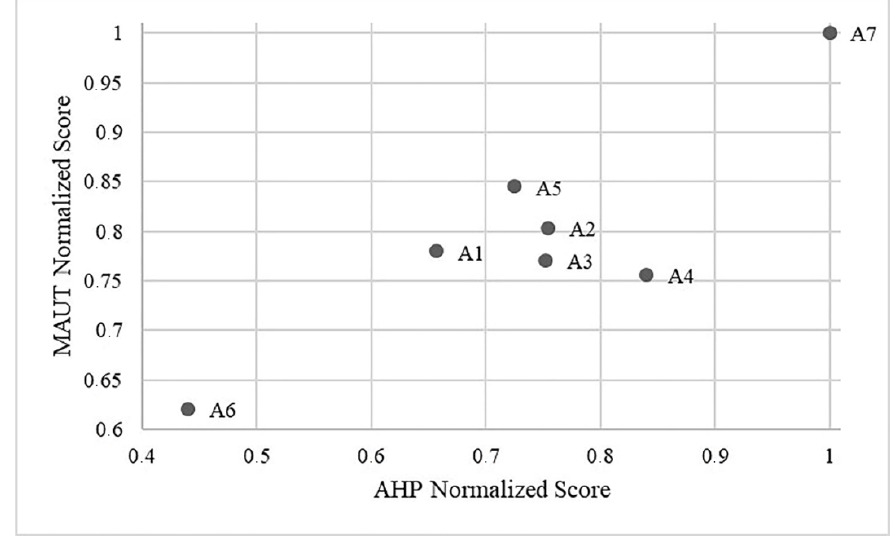
Figure 10. Normalized scores comparison for both methodologies.